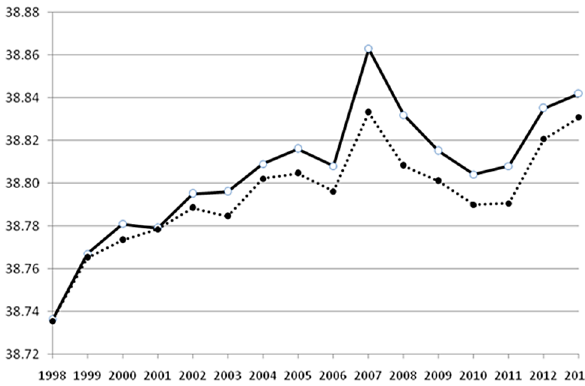
Figure 10. Mean S max values (continuous line) and mean salinity (dotted line) in the density range 29.0–29.12kgm − 3